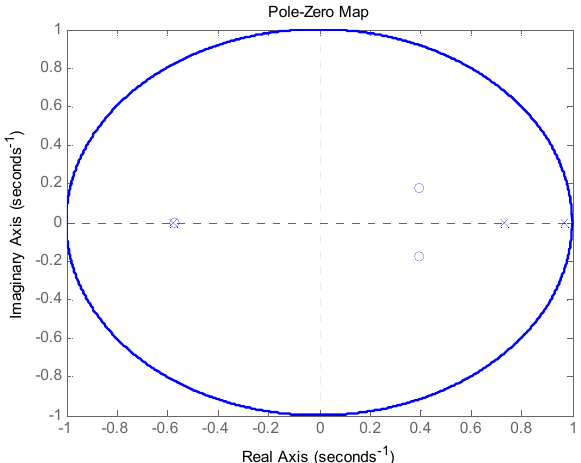
Figure 7. Positions of zeros and poles of the ARMA model with parameters (20).